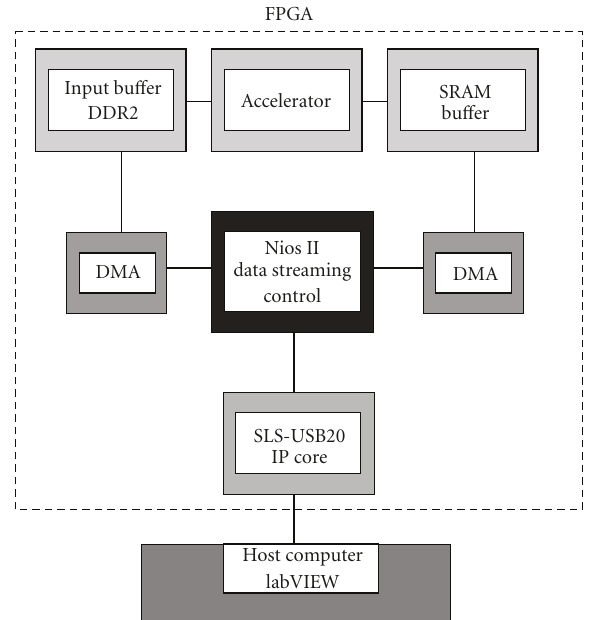
Figure 11: Hardware platform for the evaluation of the processors: system-on-a-chip and communication with host.